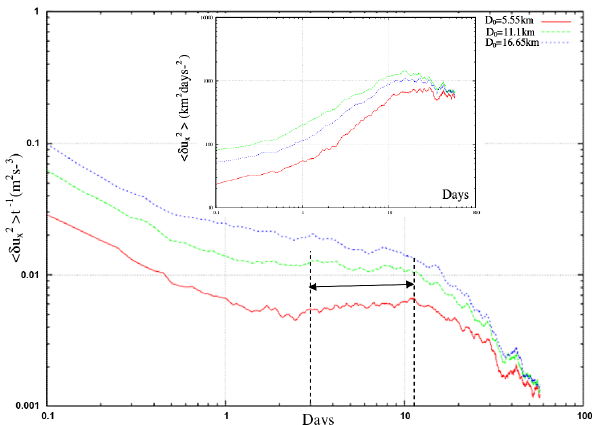
Fig. 5a. Temporal evolution of the zonal relative dispersion D 2 x . The solid black line indicates the linear law.